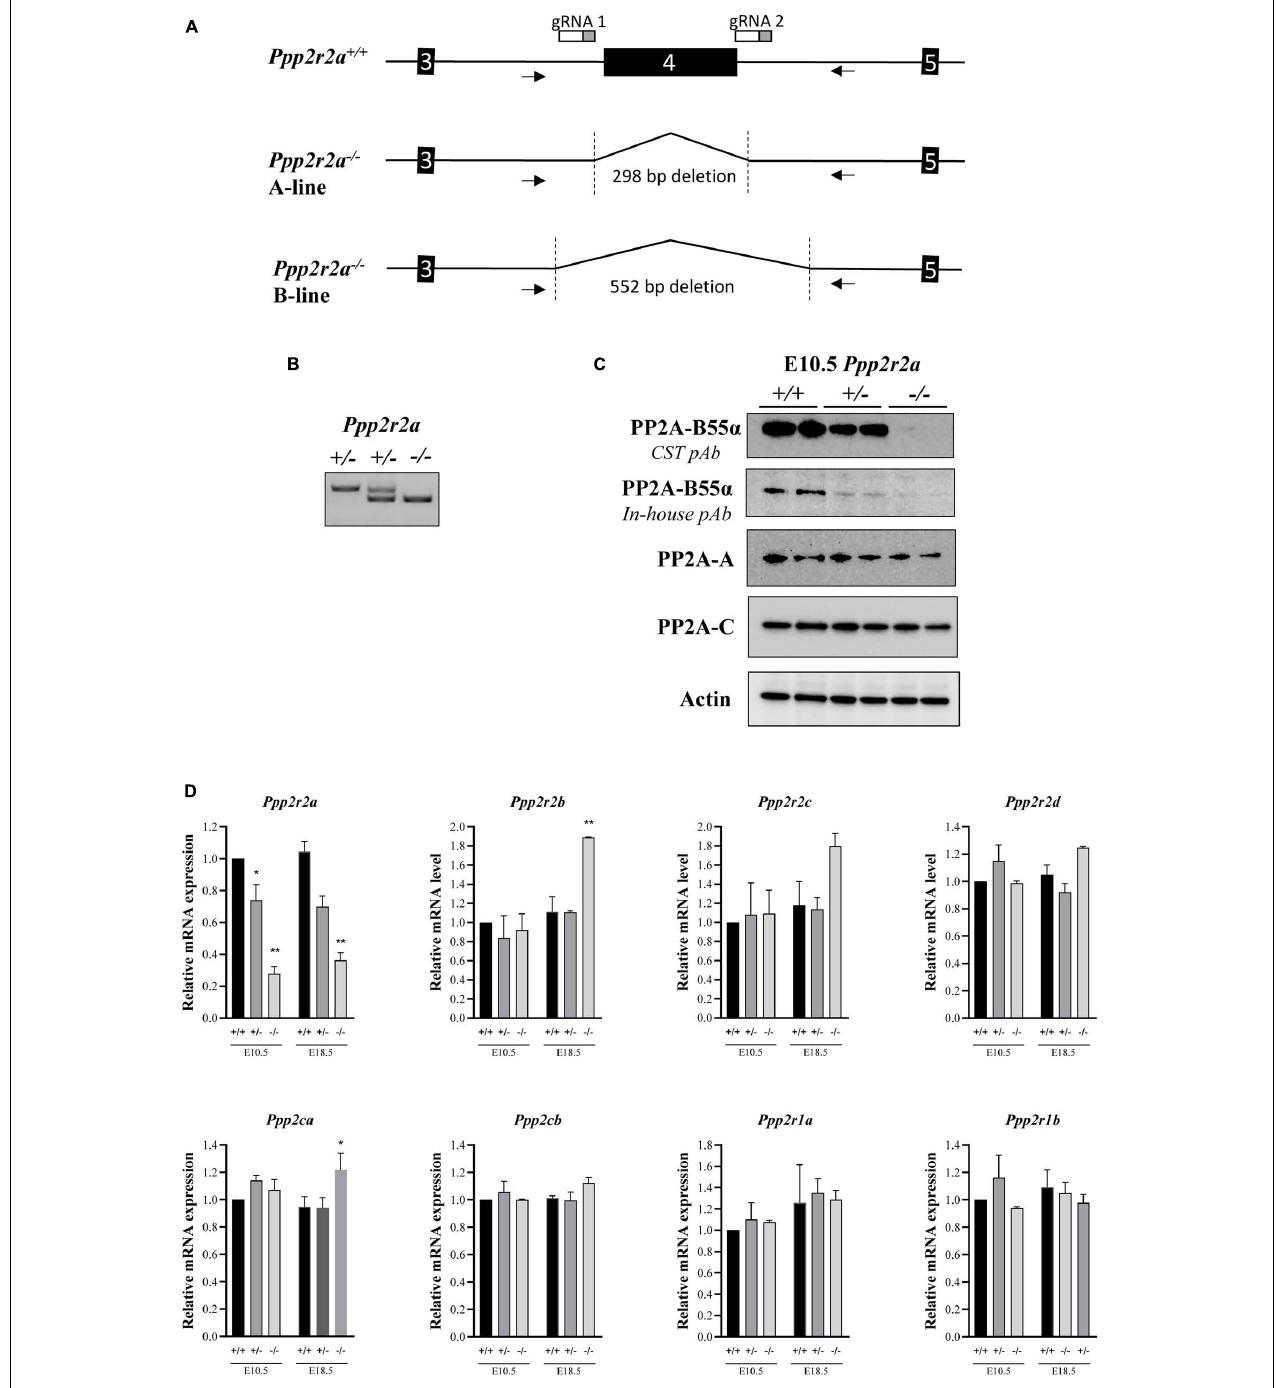
FIGURE 1 | Generation of Ppp2r2a null mice lacking B55 α protein expression. (A) Schematic of Ppp2r2a wildtype (+/+) allele and Ppp2r2a knockout alleles (–/–) from the A-line and B-line, showing the extent of deletion of exon 4 and partial flanking introns. The arrows show primer binding regions. gRNA 1 and 2 show binding site of CRISPR/Cas9 guide RNAs. (B) DNA genotyping gel of E10.5 embryos showing Ppp2r2a wild-type, heterozygous and knockout progeny. (C) Representative immunoblot of two E10.5 embryos of each genotype, revealing complete loss of PP2A-B55 α expression in Ppp2r2a knockout (–/–) embryos using a primary polyclonal antibody to PP2A-B55 α (CST #4953) and an in-house primary polyclonal antibody to B55 α as described in the methods. Representative immuno-blots of PP2A-A and –C subunits. Actin was used as a loading control. (D) The mRNA expression of the B55 subunit genes (Ppp2r2a, Ppp2r2b, Ppp2r2c, Ppp2r2d ), the PP2A catalytic subunit genes ( Ppp2ca and Ppp2cb) and the PP2A structural subunit genes ( Ppp2r1a and Ppp2r1b ) were assessed by quantitative real time PCR. Data was normalized to the housekeeping gene, Rpl19 , which was constant between genotypes and embryonic stages, and is represented as a fold change relative to the respective wildtype embryos for each stage. n = 2, * p < 0.05, ** p < 0.01, two-tailed t -test compared to wildtype.